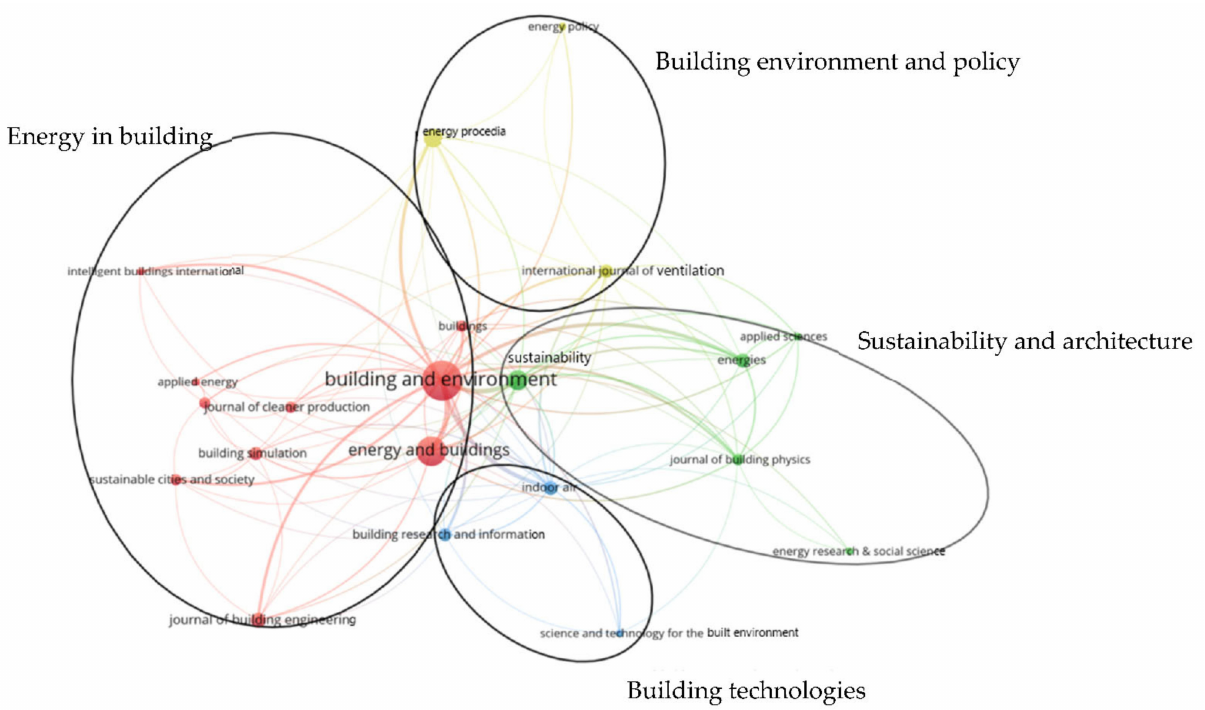
Figure 8. Leading journals network visualisation and their clusters in IEQMI research.